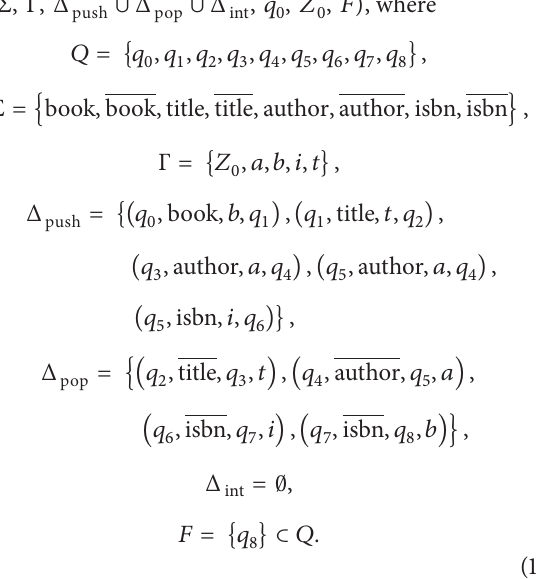
Figure 7: VPA 𝑆 3 obtained by integrating 𝑆 1 with 𝑆 2 .